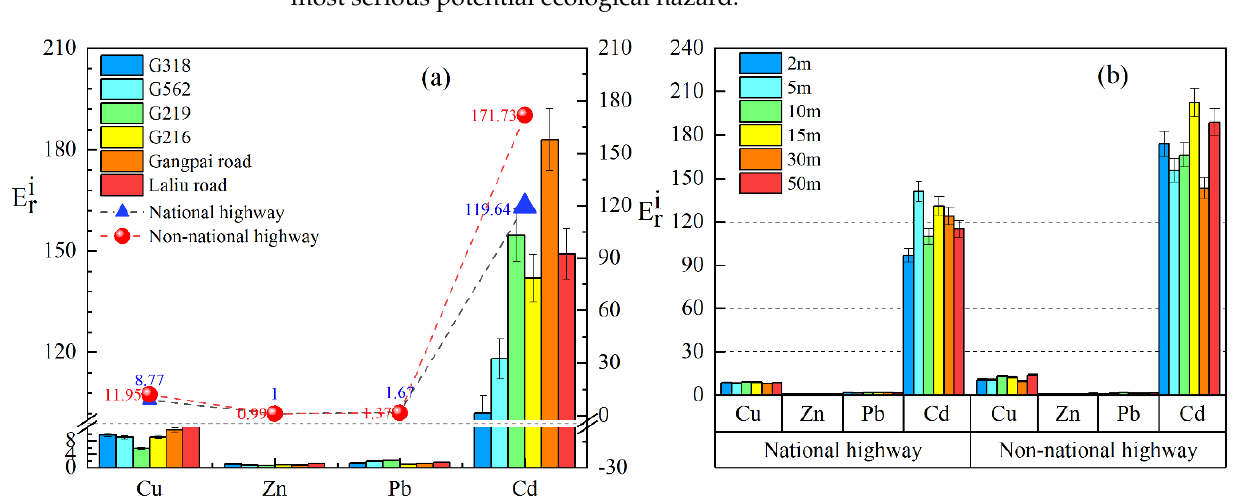
). ( a ) The average values of soil values of soil heavy metals at different dis- 𝑟𝑟𝑖𝑖 𝑟𝑟𝑖𝑖 𝐸𝐸 𝐸𝐸 𝑟𝑟𝑖𝑖 𝐸𝐸